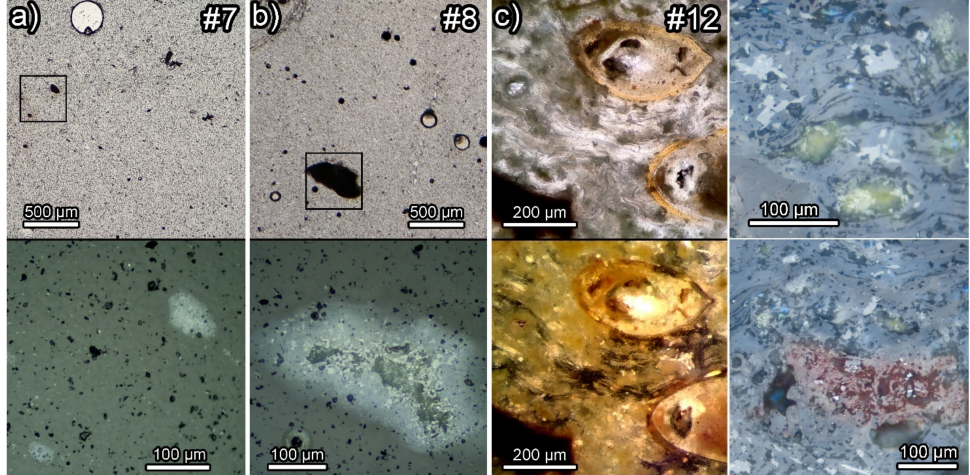
Figure 7. POM images of thin sections of the sampled glass tesserae from the Circus mosaic: ( a ) Arctic blue tessera #7, PPL ( top ) and RL ( bottom ) corresponding to the square enclosing opaque inclusions; ( b ) dark azure tessera #8, PPL ( top ) and RL ( bottom ) corresponding to the square area enclosing opaque inclusions; ( c ) sage green tessera #12, on the left general view including large pores and the matrix as seen in PPL ( top ) and XPL ( bottom ), on the right enlarged areas viewed under RL displaying gray and yellow microcrystal inclusions ( top ) and a reddish clod ( bottom